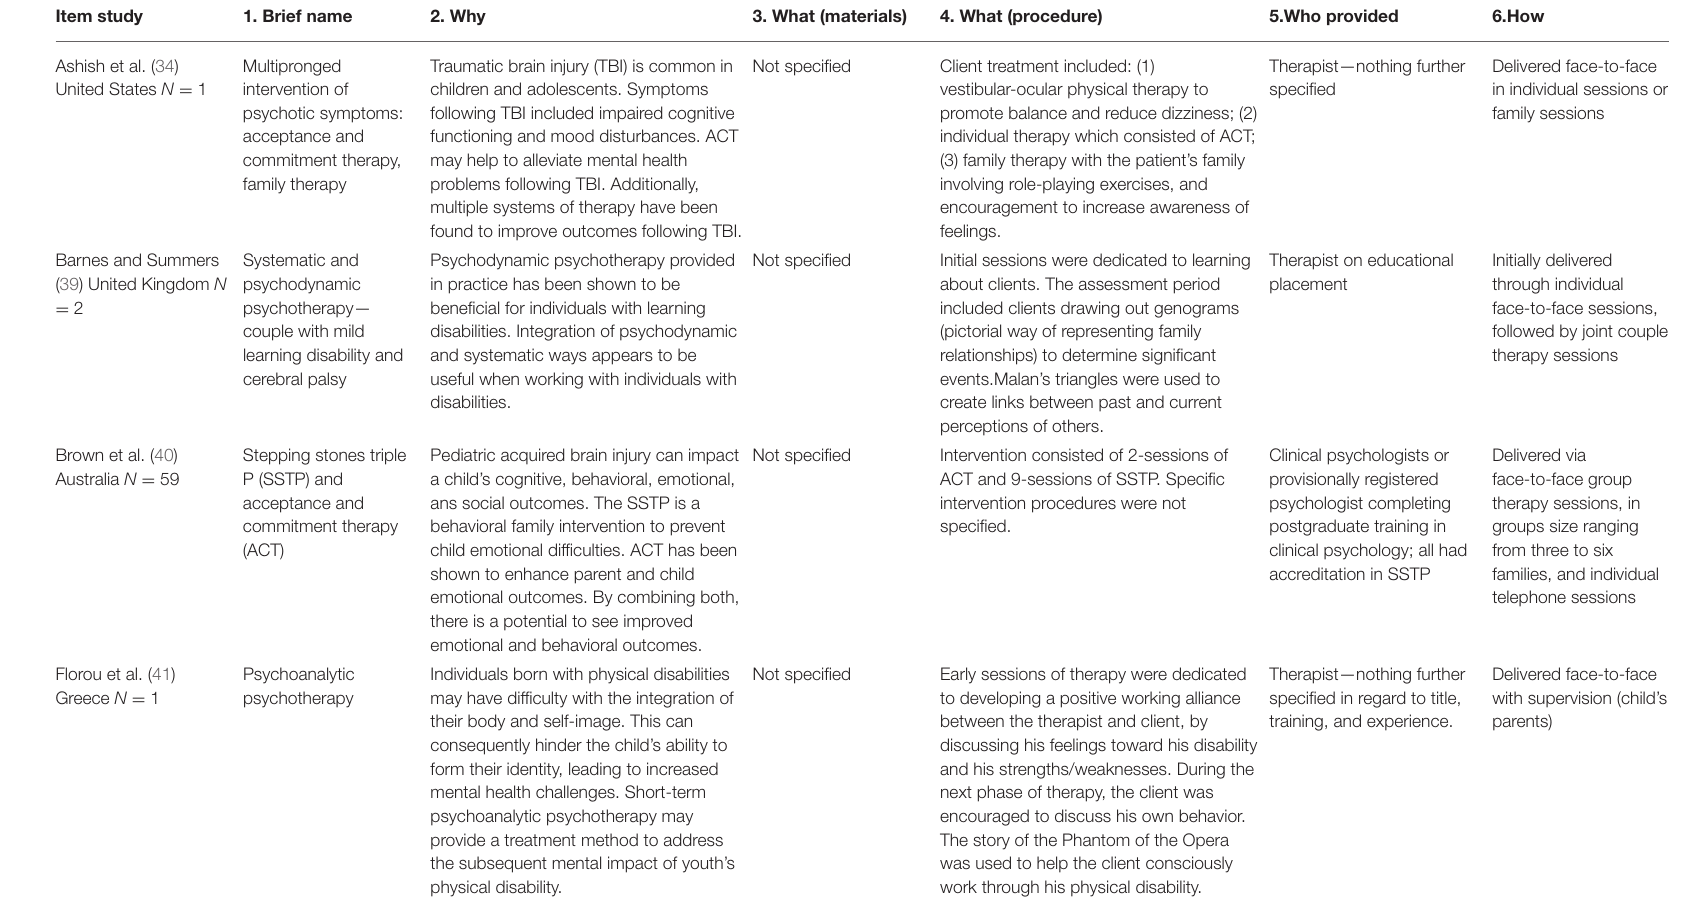
TABLE 1 | Summary of psychological interventions using the TIDieR framework items one through